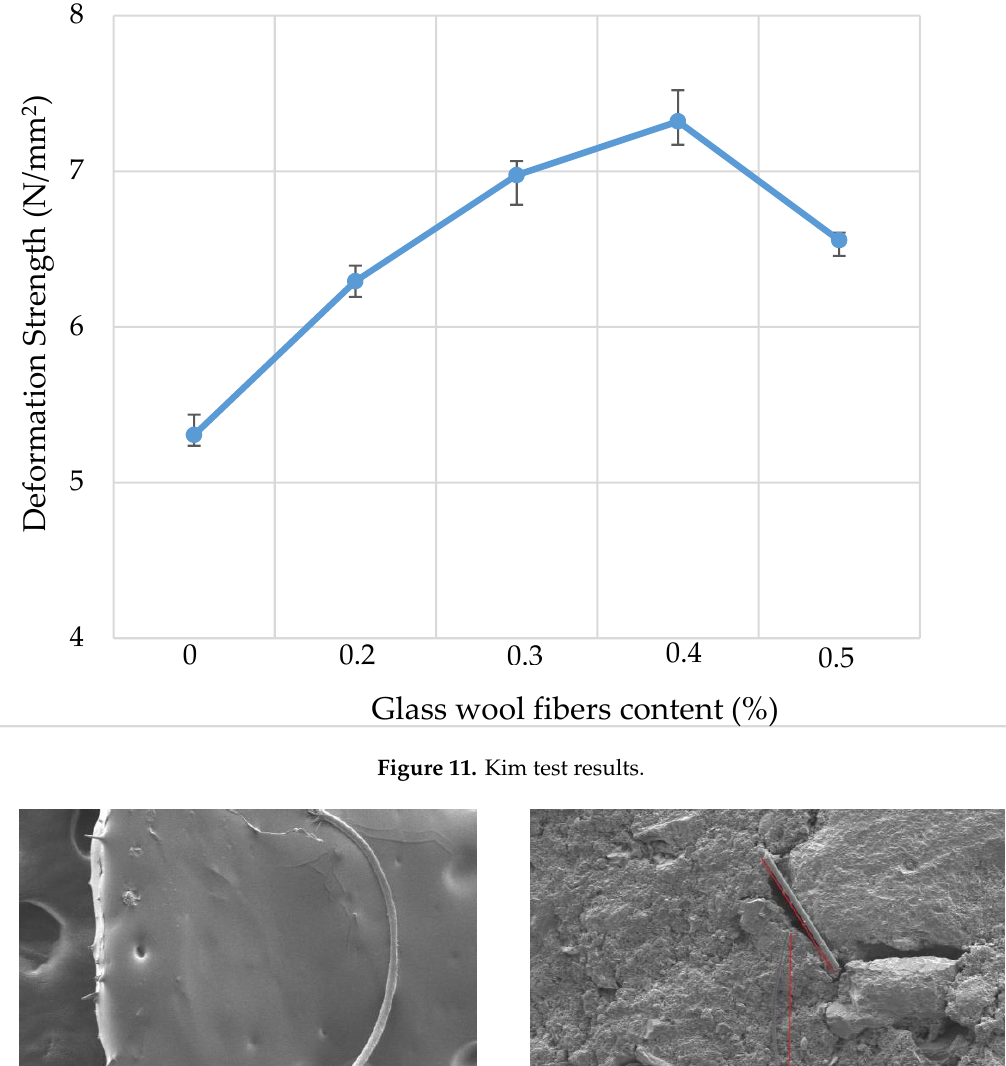
Figure 12. ( a ) Glass wool fibers mixed with asphalt binder and ( b ) asphalt concrete (AC) mixture with reinforced fibers .